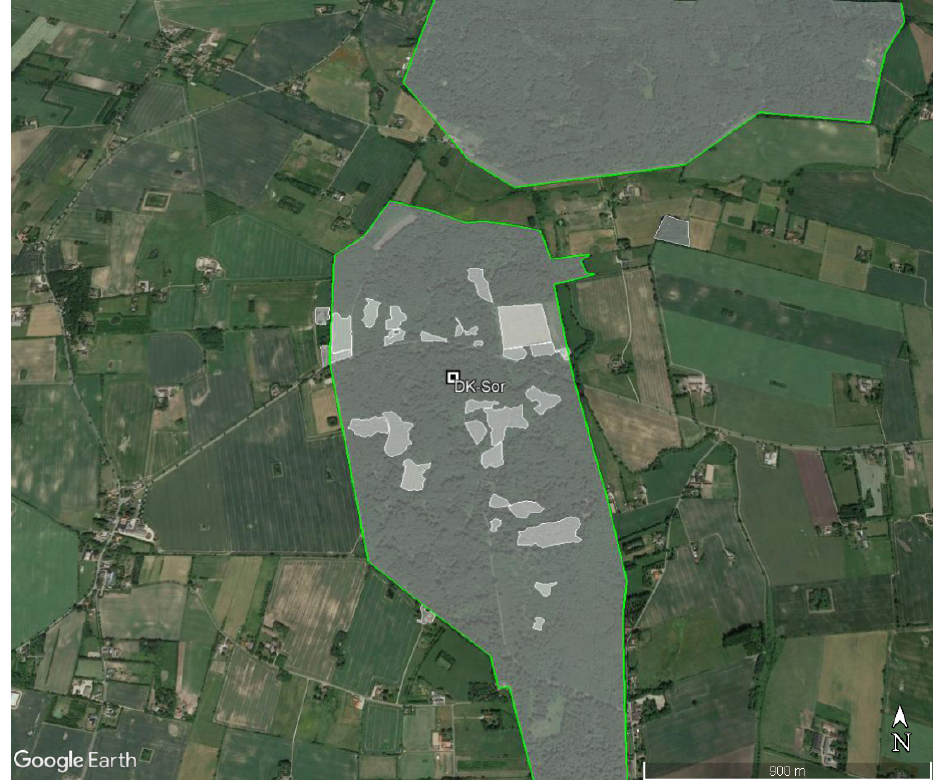
Figure 1. Aerial image of the DK-Sor site. Beech forest is indicated by a polygon with a green edge, and the exclusion areas, i.e. patches of coniferous trees, inside the Lille Boegeskov beech forest are indicated by polygons with a white edge, © Google